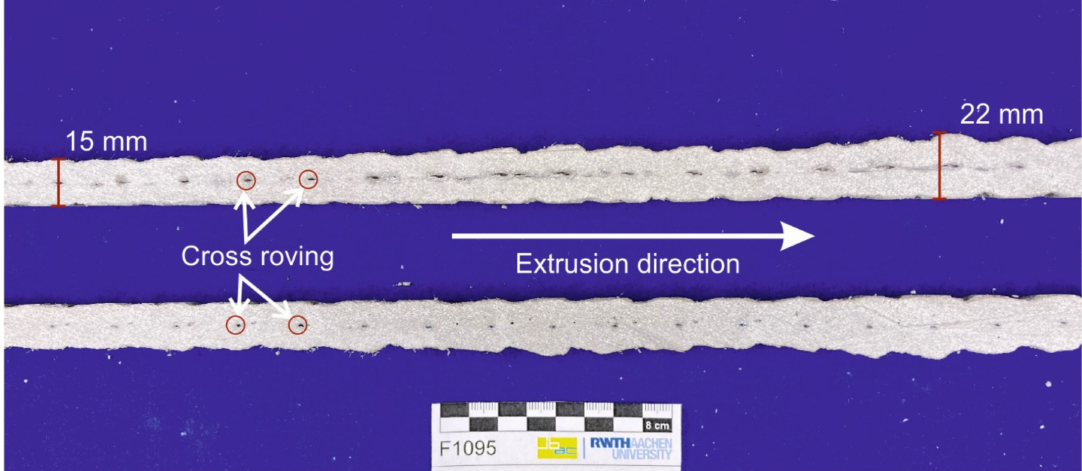
Figure 12. Longitudinal section of the extrusion body with textile